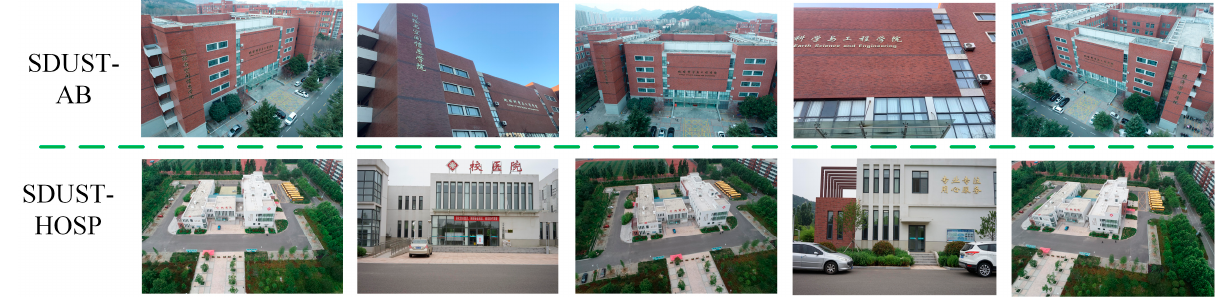
Figure 8. Partial images of the SDUST-AB and SDUST-HOSP datasets.